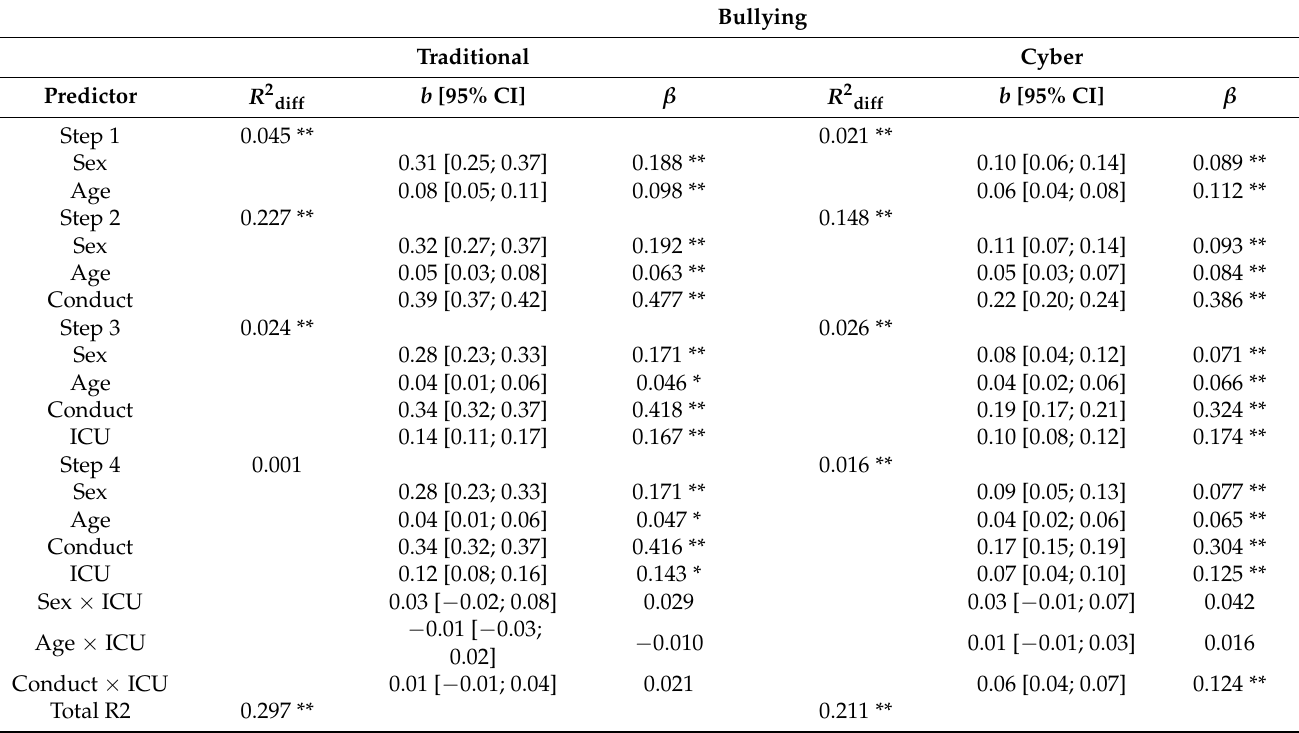
Table 3. Hierarchical multiple regression analyses predicting traditional and cyberbullying from sex, age, conduct problems, ICU, and their interaction.